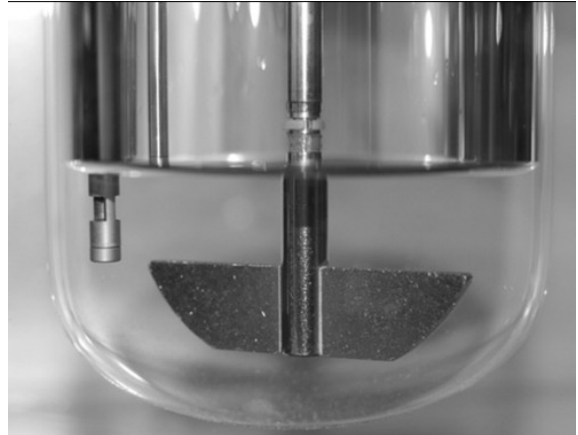
Figure 10. Modified dissolution setup to perform in-line dissolution monitoring of rapidly releasing drug dosage forms using paddle apparatus and 300 mL dissolution